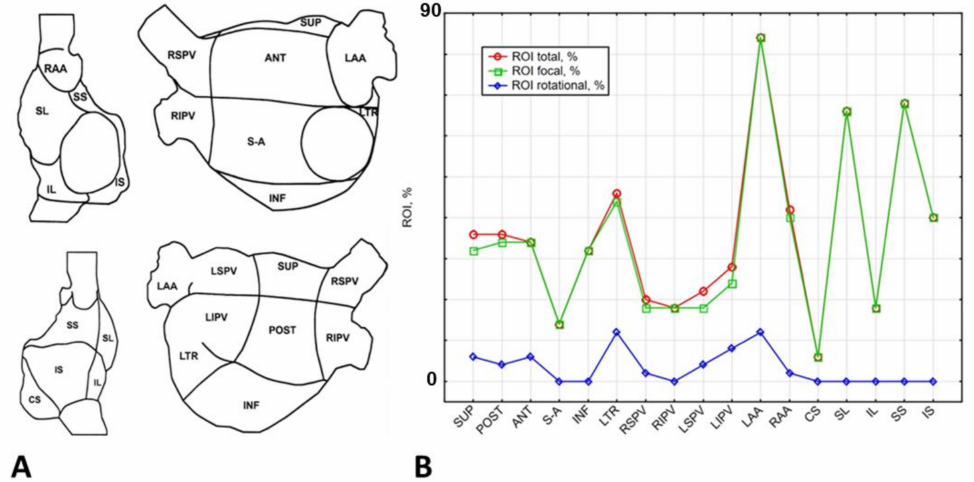
Figure 3. ( A ) Schematic reconstruction from of the right (RA) and left atrium (LA) in ante- rior/posterior (AP) and posterior/anterior (PA) view. The RA was divided into the following segments: right atrial appendage (RA RAA), coronary sinus ostial area (RA CS), superior lateral (RA SUP LAT), inferior lateral (RA INF LAT), superior septal (RA SUP SEP), inferior septal (RA INF SEP), superior cava vein (SCV), and inferior cava vein (ICV). The LA was divided into the following segments: superior (LA SUP), posterior (LA POST), anterior (LA ANT), inferior (LA INF), lateral (LA LAT), right superior pulmonary vein (LA RSPV), right inferior PV (LA RIPV), left superior PV (LA LSPV), left inferior PV (LA IPV), septal-anterior (LA SEPT ANT), and left atrial appendage (LAA). ( B ) Distribution of Regions of Interest (ROI; red color, focal + rotational; green color, focal; blue color, rotational) from CARTOFINDER mapping separated per atrial